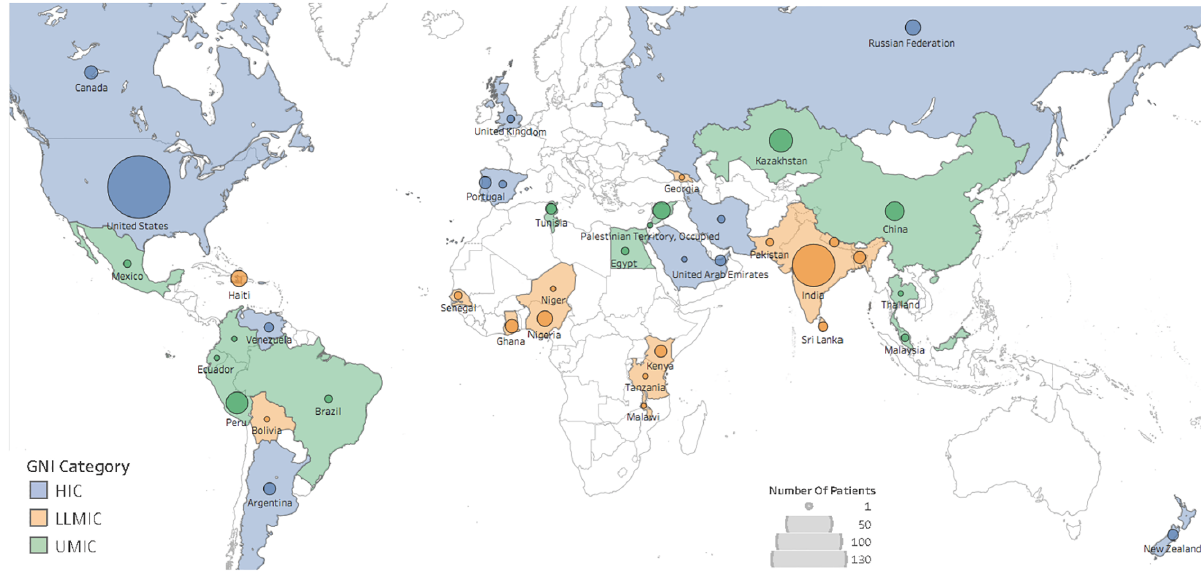
Fig 1. Patient distribution based on GNI category and geographical region. Color based on Gross national income, size of marks based on number of patients enrolled by country. HIC: high income country; UMIC: upper middle-income country; LLMIC: low and low middle income country. This graphic was made in Tableau